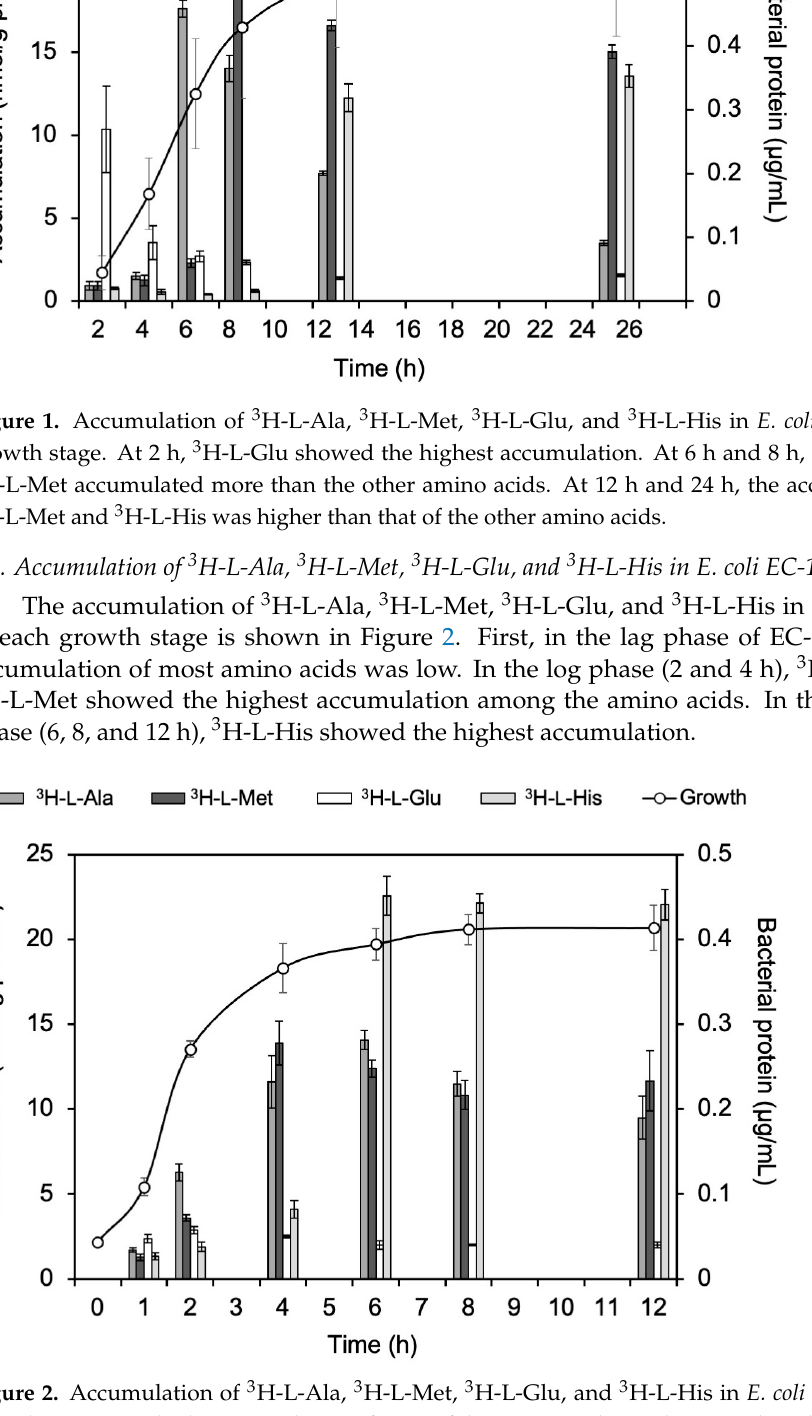
( b ) Figure 3. Accumulation of 3 H-L-Ala in ( a ) E. coli K-12 and ( b ) EC-14 at each growth stage. H-L-Ala accumulation in K-12 showed the highest uptake during the log phase, but not much uptake during the stationary phase. In contrast, the accumulation by EC-14 remained high from the logarithmic growth stage to the stationary phase.